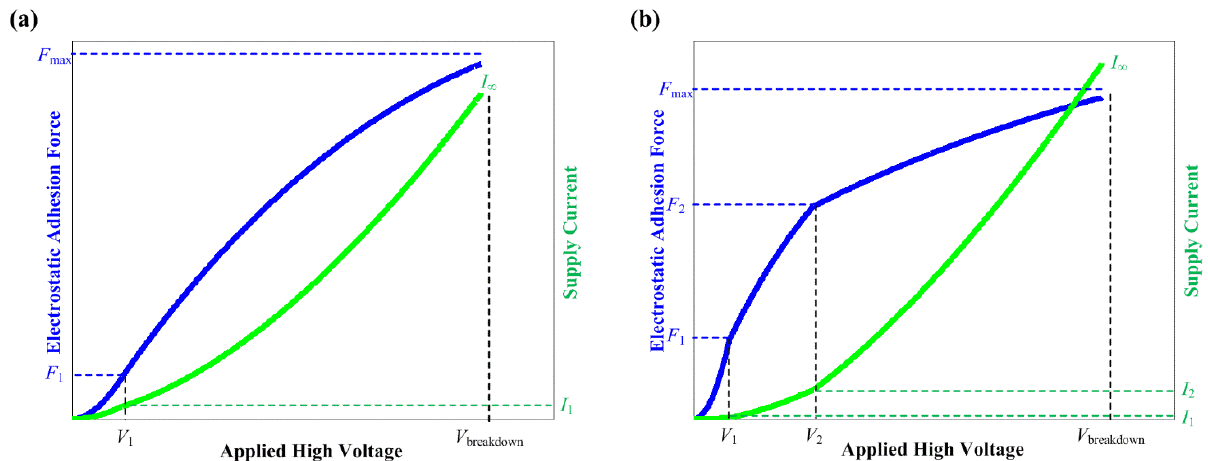
Figure 12. The working model for the electroadhesion actuator depicting ( a ) the second order characteristics and ( b ) the third order